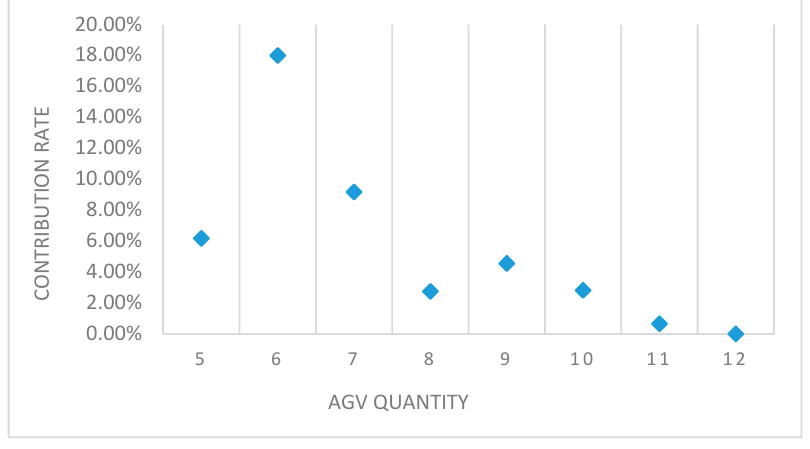
Figure 20. Impact of AGV quantity on completion time under the cross-regional shared resource pool.